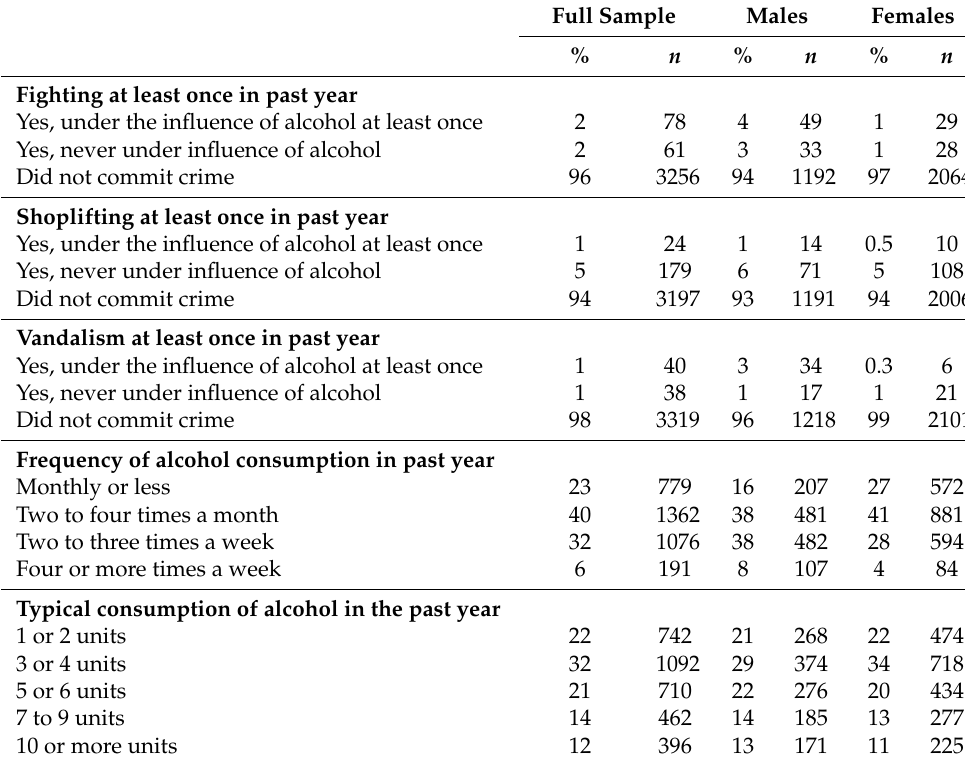
Table 2. Prevalence of each type of crime (fighting, shoplifting and vandalism) and whether it was committed under the influence of alcohol and alcohol consumption